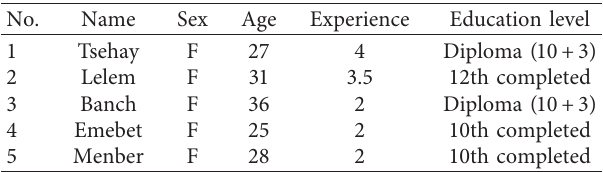
Table1: Chrematistics of the IFAE program facilitators who par- ticipated in this